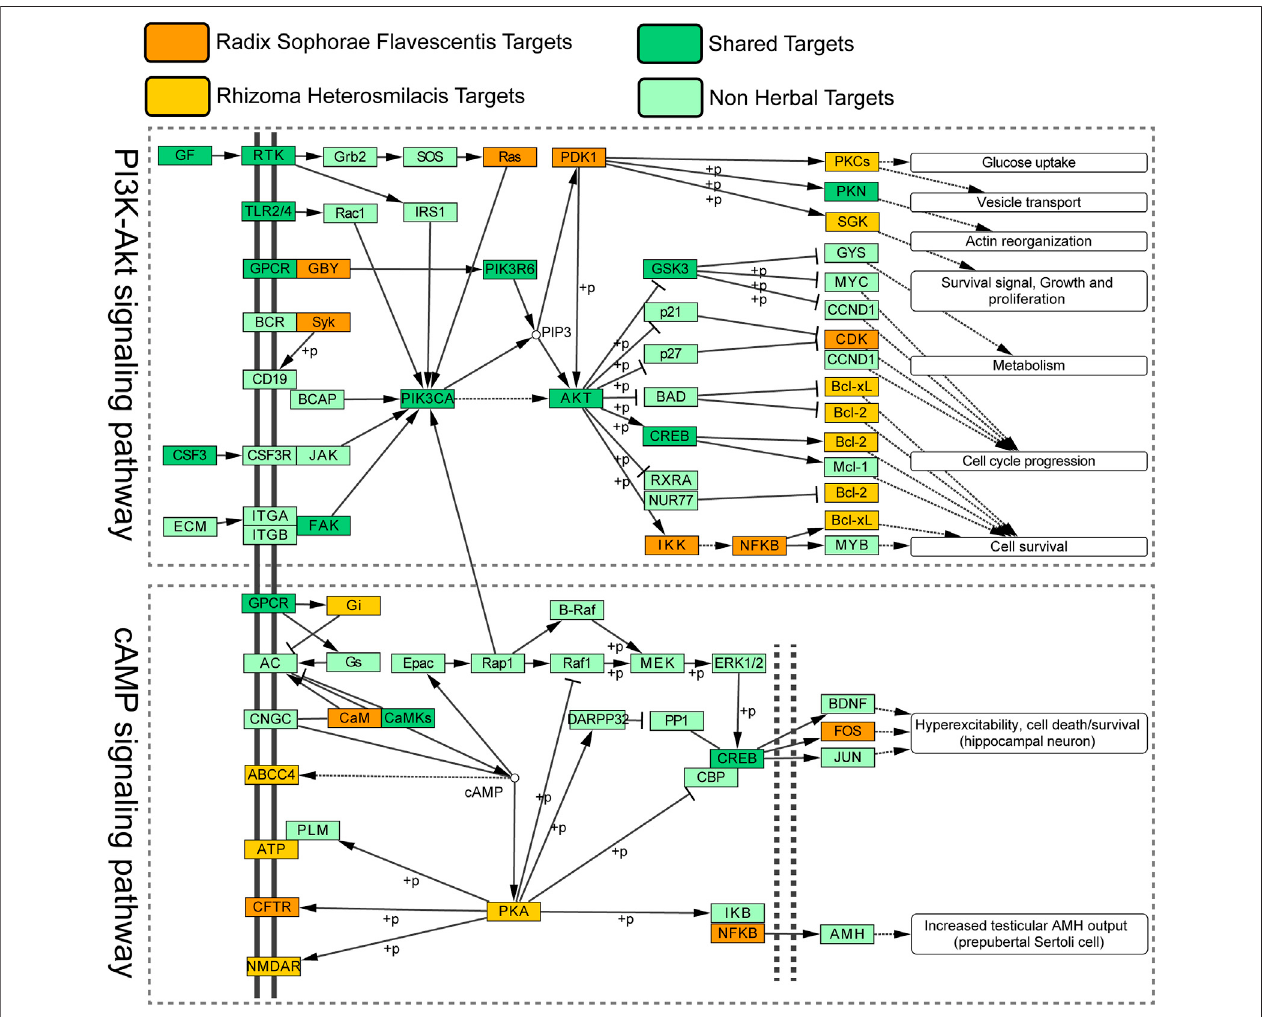
FIGURE 6 | Distribution of target proteins of CKI on the compressed BC pathway. The colors of the blanks represent different types of targets.